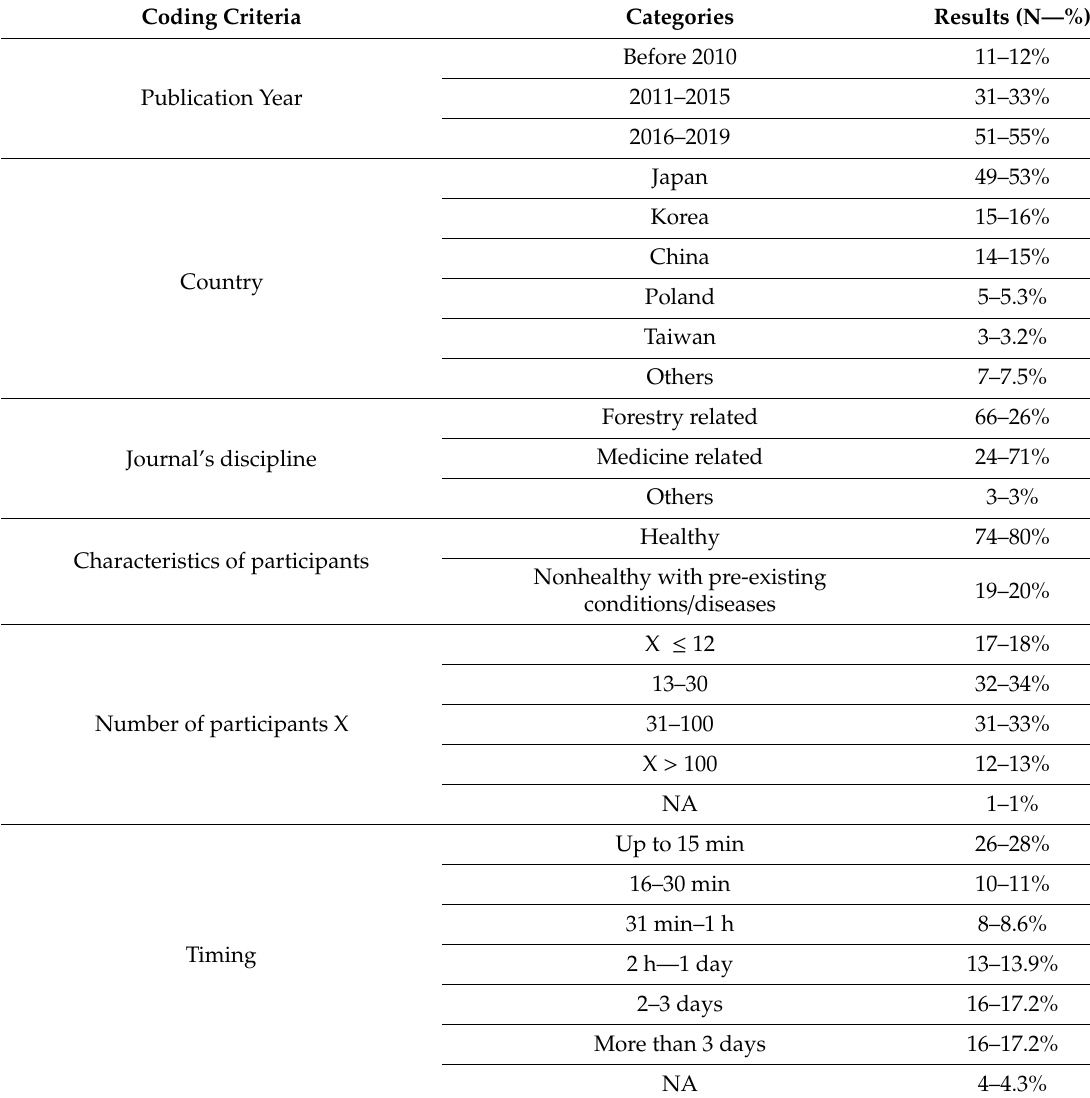
Table 1. Summary of results of the literature